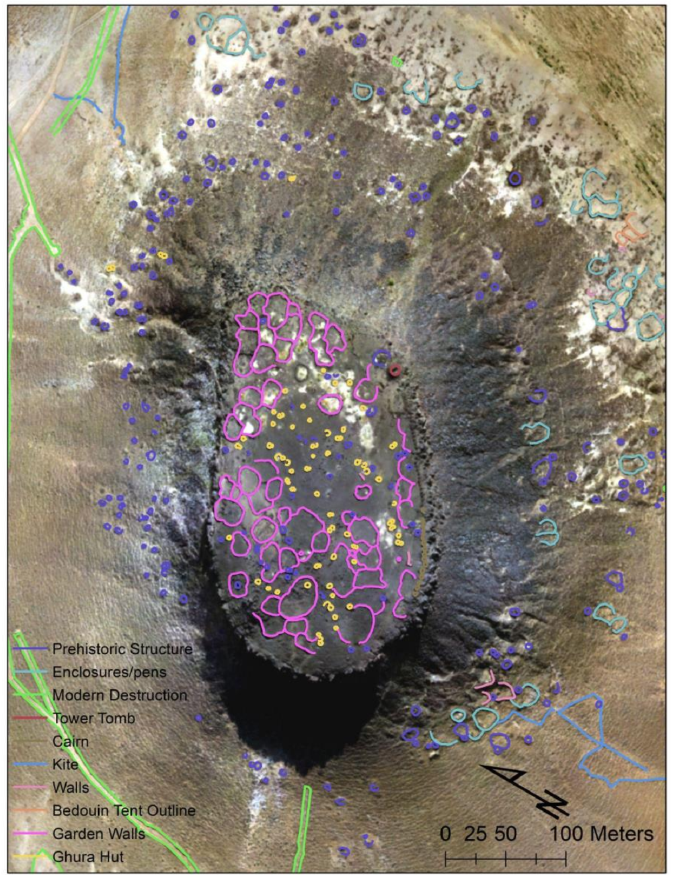
Figure 12. Closeup of M4, with orthophoto basemap, showing clustering of structures on the lower slopes, and ghura huts and garden walls on the